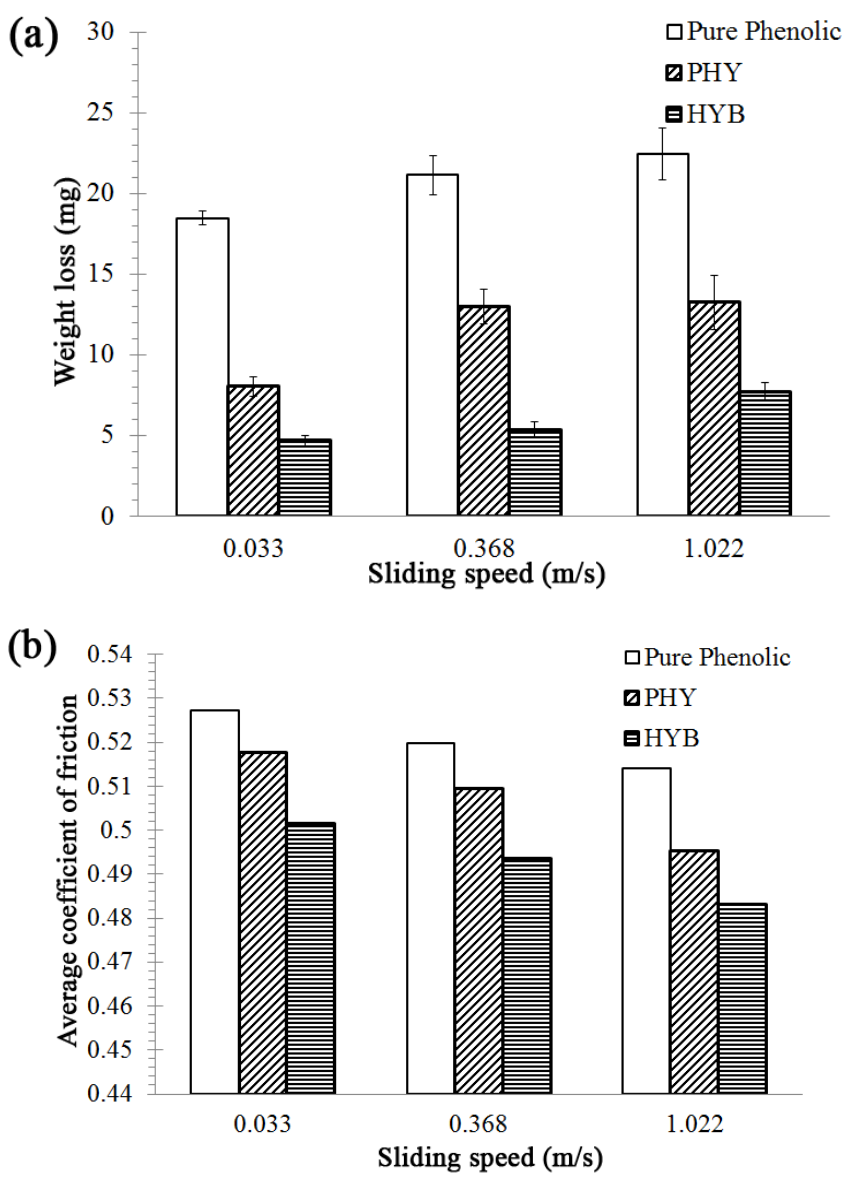
Figure 5. Properties of the HYB composite and PHY composite after wear tests for different materials with the variation in sliding speed (load: 10 N, Filler: 5 wt%): ( a ) weight loss, and ( b ) average coefficient of friction.